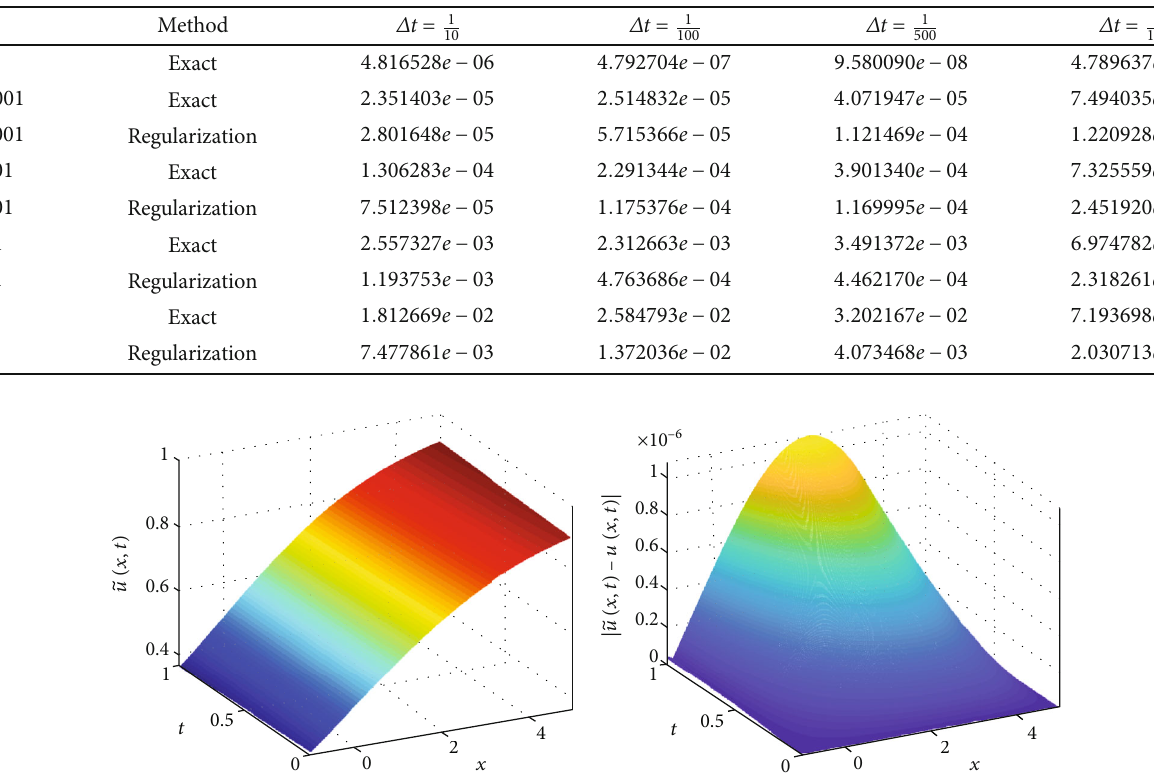
Table 3: L ∞ errors of Example 3 for di